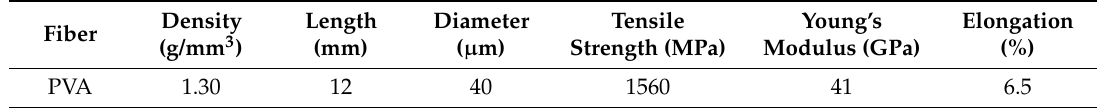
Table 1. Properties of polyvinyl-alcohol (PVA) fiber.